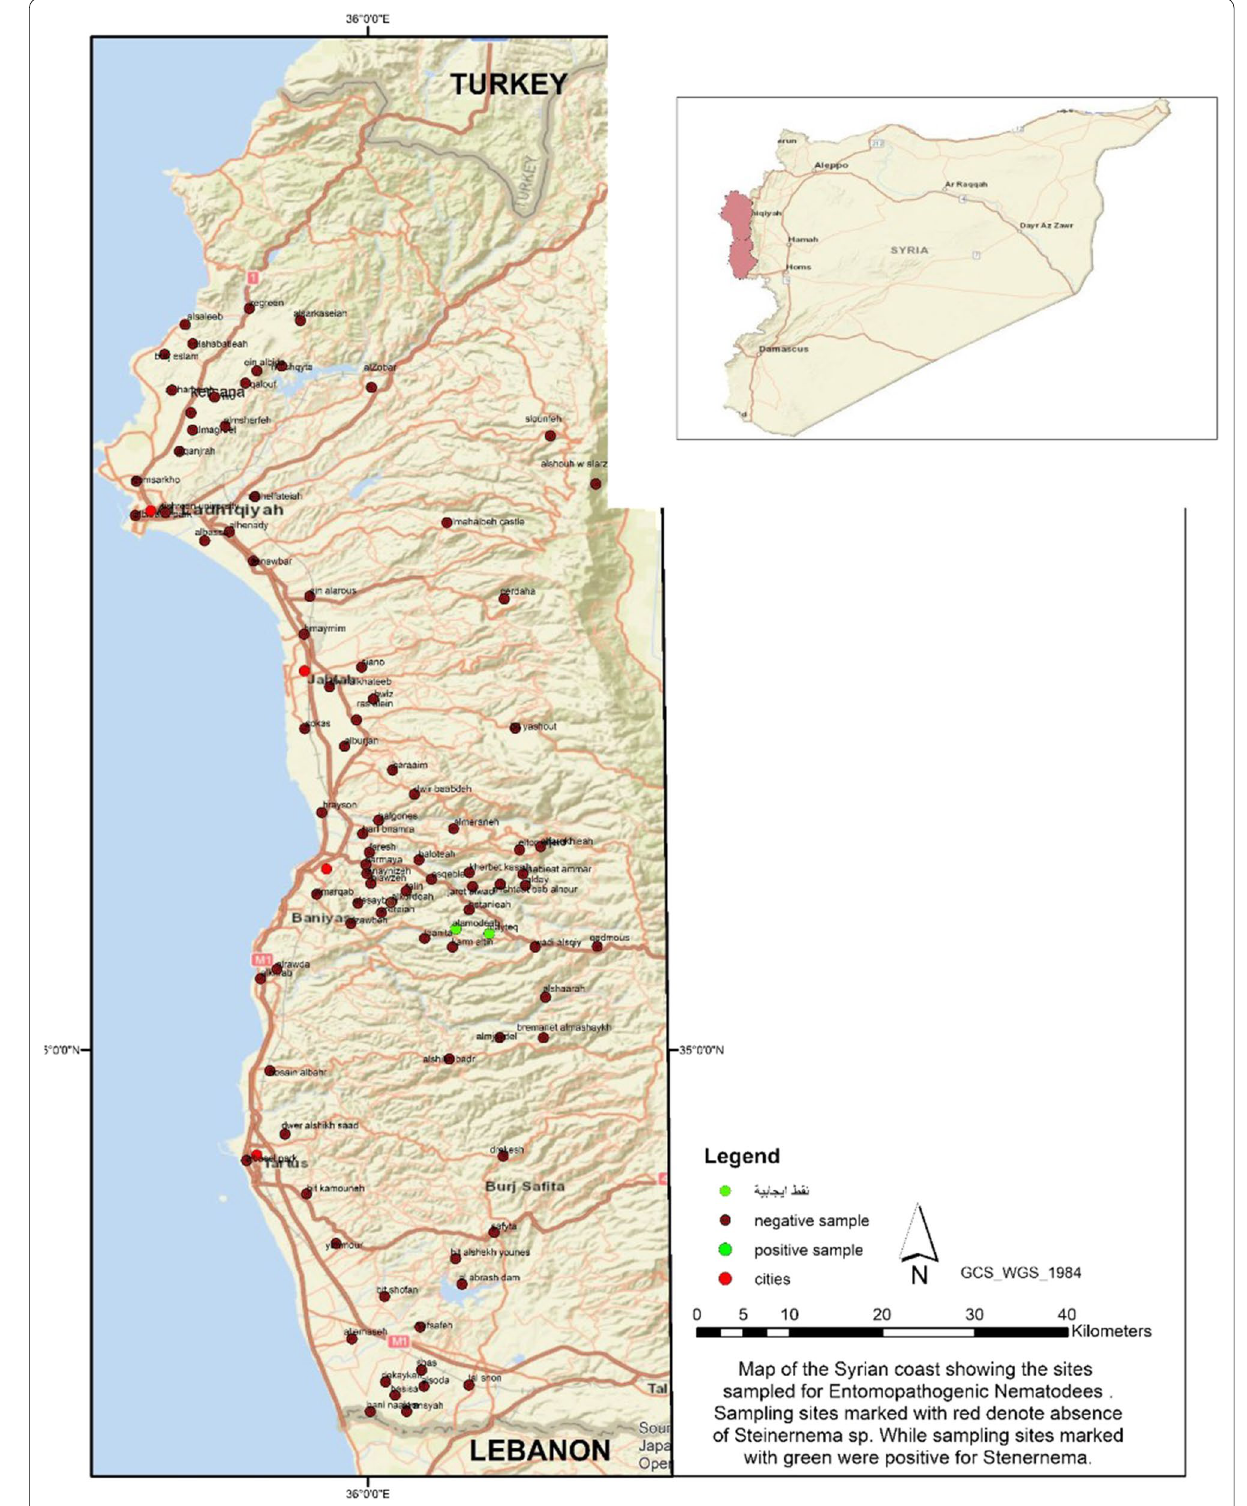
Fig. 1 Map of the Syrian coastal region showing the sites sampled for entomopathogenic nematodes. Sampling sites marked with red denote the absence of Steinernema sp., while sampling sites marked with green were positive for